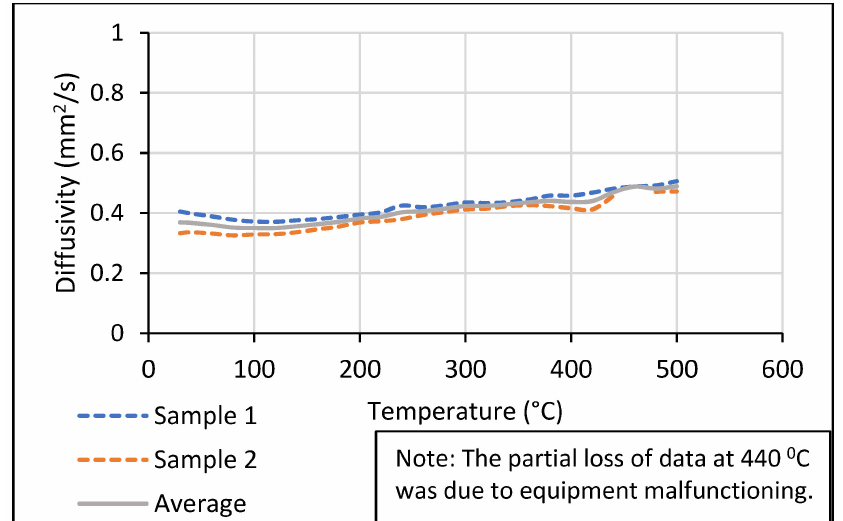
Figure 5. Thermal diffusivity of expanded